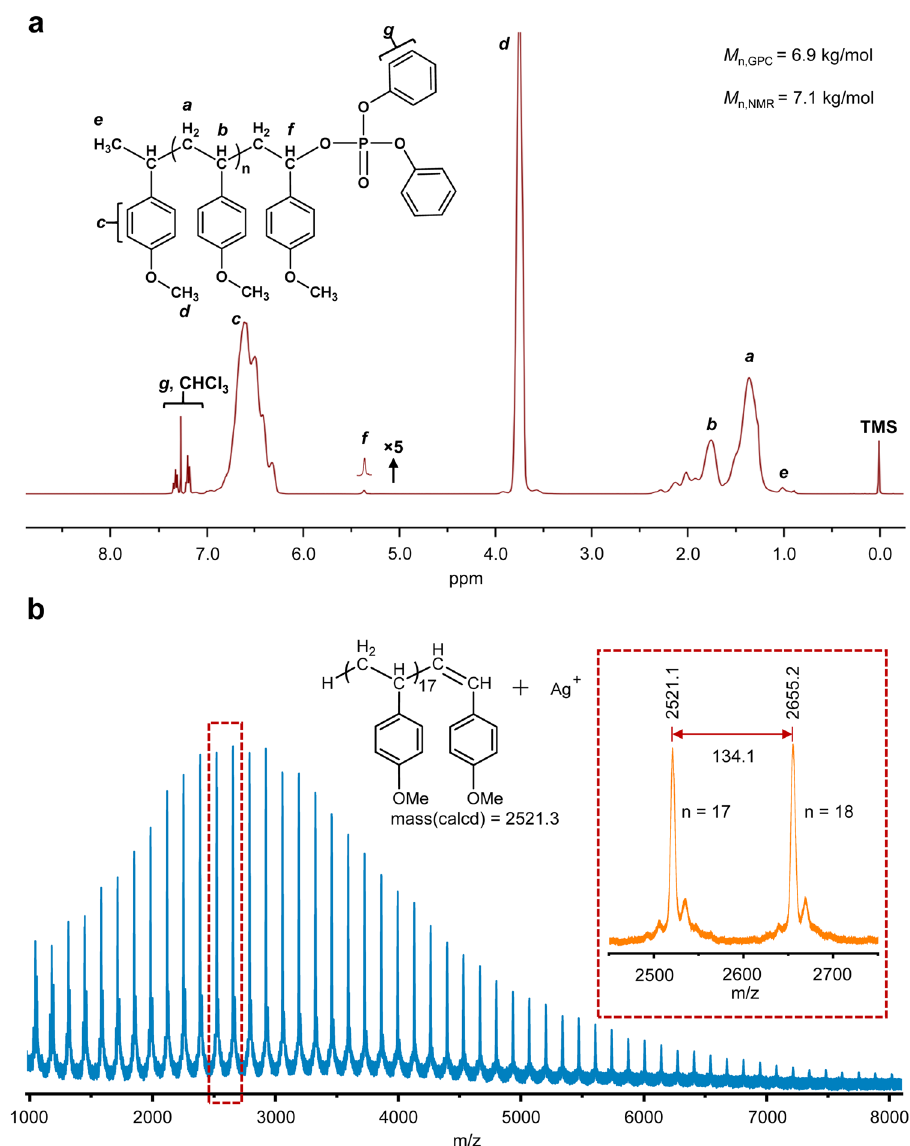
Fig. 3 Characterizations of the polymers. a 1 H NMR and b MALDI-TOF mass spectra of the resulting poly( p -MOS) with red box in the top right showing two peaks of 2521.1 and 2655.2 corresponding to poly( p -MOS) ( DP n = 18 and 19) cationized by silver and bearing a terminal group of